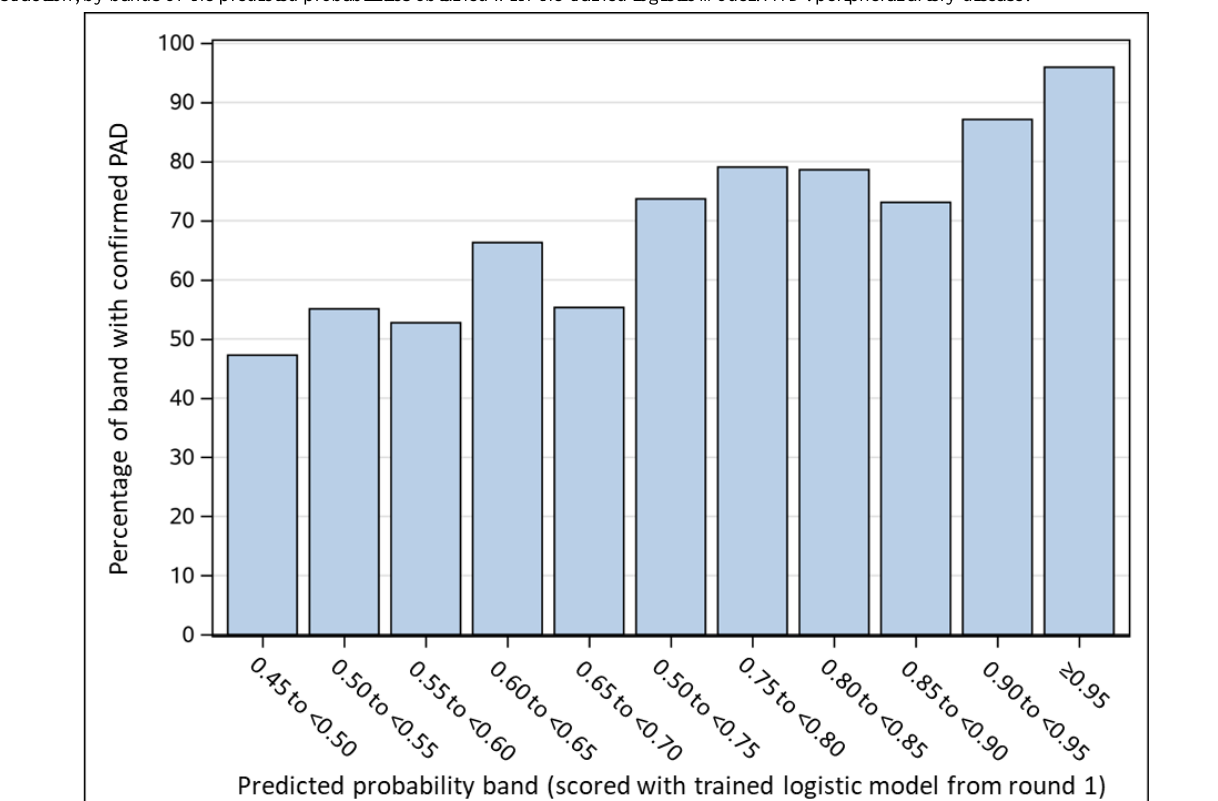
Figure 4. Model performance. Proportion of patients who were selected for the second round of abstraction who were confirmed to have PAD via abstraction, by bands of the predicted probabilities obtained with the trained logistic model. PAD: peripheral artery